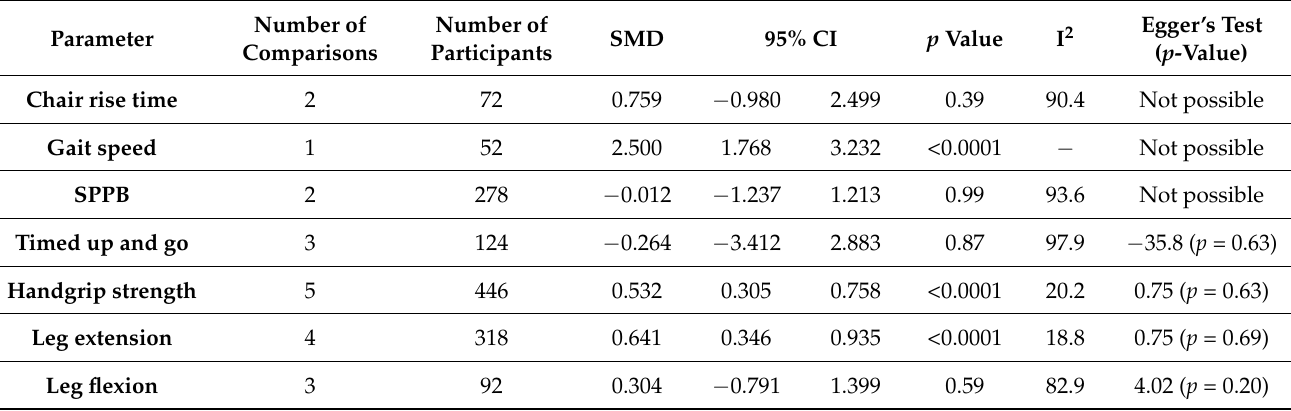
Table 2. Effect of calcifediol oral supplementation on physical performance and muscle strength parameters.